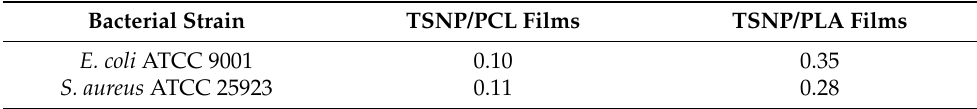
Table 2. Antimicrobial effect (AE) values * for TSNP-treated